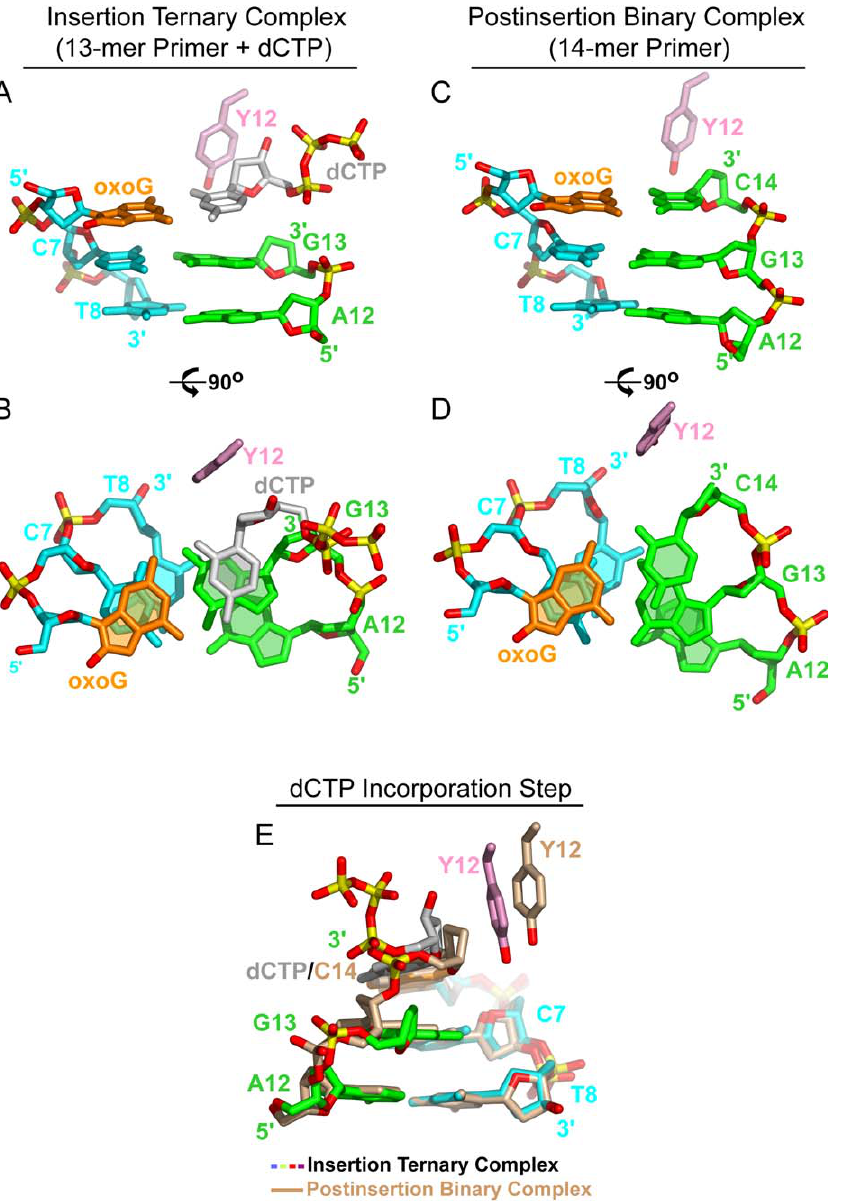
Figure 8. Relative Positioning of the oxoG (cid:2) dCTP Pair in the Insertion Ternary Complex and the oxoG (cid:2) C Pair in the Postinsertion Binary Complex (A) View of the (oxoG6-C7-T8) (cid:2) (A12-G13) segment plus dCTP and Y12 in the modified ternary complex. The aromatic ring of Y12 is packed against the sugar ring of the incoming dCTP. (B) View of (A) looking down the helix axis. (C) View of the (oxoG6-C7-T8) (cid:2) (A12-G13-C14) segment and Y12 in the postinsertion binary complex. (D) View of (C) looking down the helix axis. (E) Superposition of the (oxoG6-C7-T8) (cid:2) (A12-G13) segment plus dCTP and Y12 of the modified ternary complex (in color) with the (oxoG6-C7-T8) (cid:2) (A12- G13-C14) segment and Y12 of the posinsertion binary complex (in beige) by the oxoG6-C7-T8 and G6-C7-T8 template strands segments. Note the relative positioning of the sugar ring of dCTP/C14 and the aromatic ring of Y12 in the two